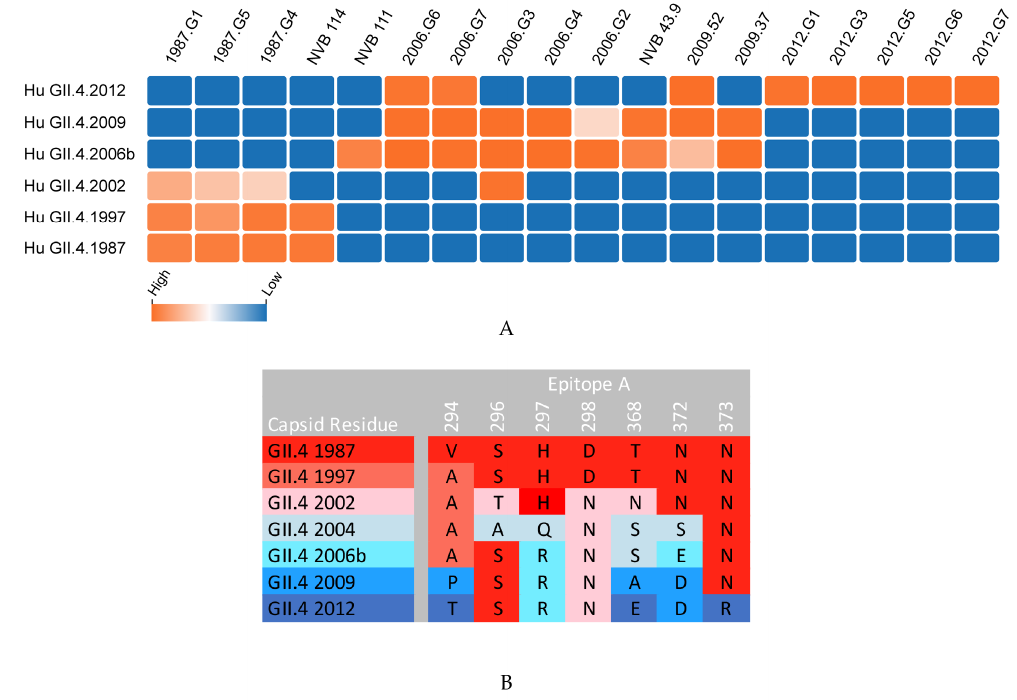
Figure 2. Mouse and human anti-epitope A monoclonal antibody blockade of time-ordered GII.4 strain virus-like particles (VLP). ( A ) Monoclonal antibodies to epitope A were generated in response to the immunization of mice with GII.4 VLPs (1987, 2006, 2009, 2012 mAbs) or the infection of humans (NVB mAbs), and their IC 50 for the blockade of VLP-ligand binding declined from highly potent (orange) to no inhibition (blue) as reported in References [25,26,38,39,60,61]. GII.4 2004 data not available. ( B ) Antigenic drift within epitope A limits the breadth of mAb recognition of epitope A.